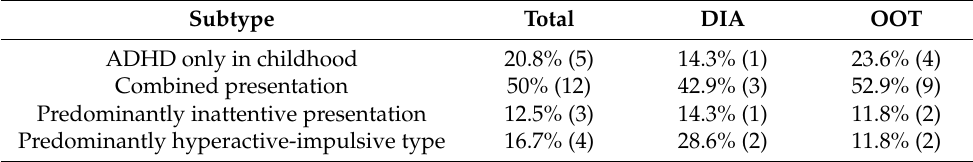
Table 1. DIVA 2.0 subtype results. Absolute numbers of participants are in parantheses.